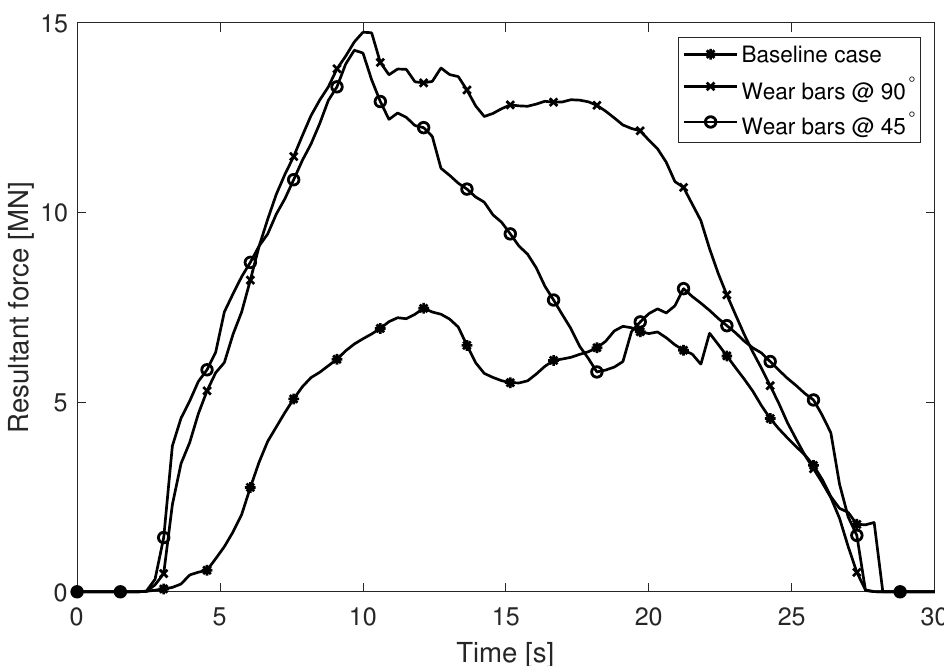
Figure 21. Resultant contact interface forces acting on the bucket (excluding lip) for the baseline bucket and the buckets with added features. The average forces are 4.2 MN, 8.0 MN, and 6.8 MN, for the baseline case, wear bars at 90 ◦ , and for the wear bars at 45 ◦ , respectively. In Figure 16, the locations of the buckets at different times during the bucket filling are